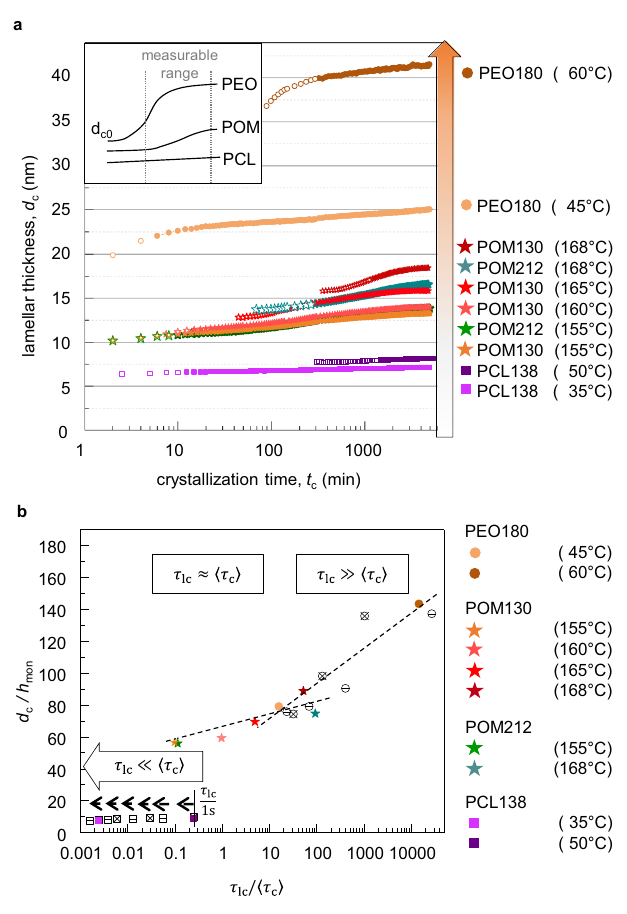
Fig. 4 Direct comparison of the crystalline thickness d c for PCL, POM, and PEO. a d c during isothermal crystallization for all crystallization temperatures. The orange arrow represents the increasing in fl uence of the ICD according to Fig. 2. The change from open to closed symbols indicates the completion of the primary crystallization. b Normalized lamellar thickness d c at the end of primary crystallization vs. the ratio of the timescales τ lc / 〈 τ c 〉 . Depending on the ratio τ lc / 〈 τ c 〉 different regimes are visible. The dotted lines are guides to the eye. The closed symbols are the data from a , open symbols represent already published data of PEO (open circles) and PCL (open squares) for two molecular weights (cross and line) measured at different T c 21 . For PCL a constant value of 1 s was taken for 〈 τ 〉 , corresponding to the lower limit of a possible α c c -relaxation time and an upper limit of τ lc / 〈 τ c 〉 as indicated by the broken arrow. Source data of a are provided as a Source Data fi